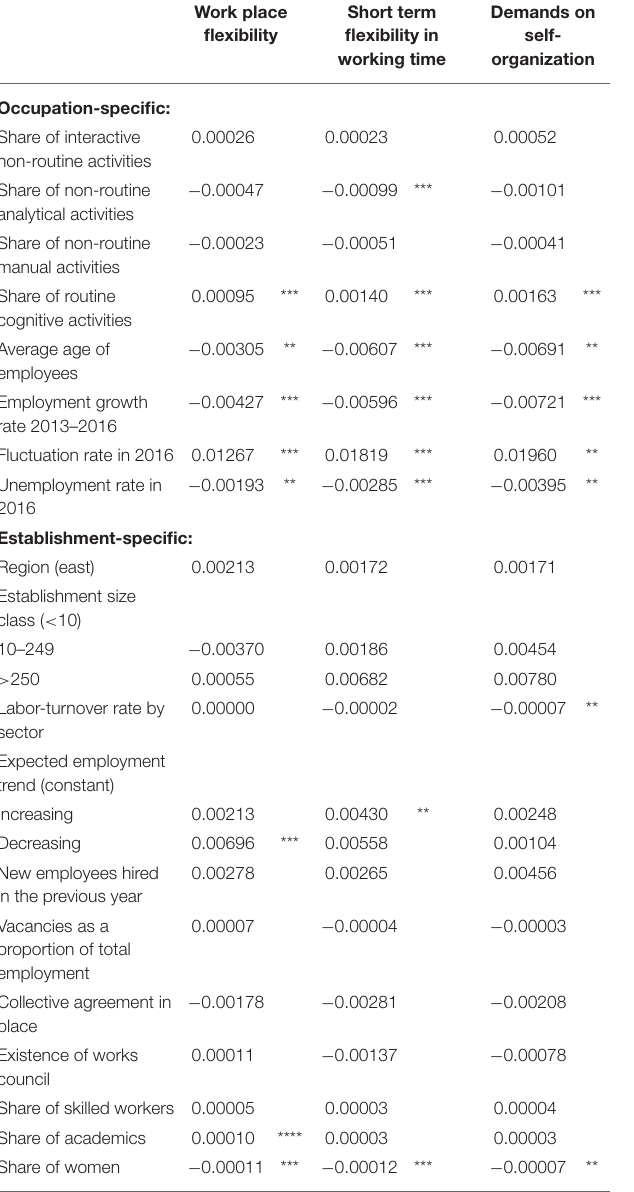
Work place Short term Demands on flexibility flexibility in self- working time